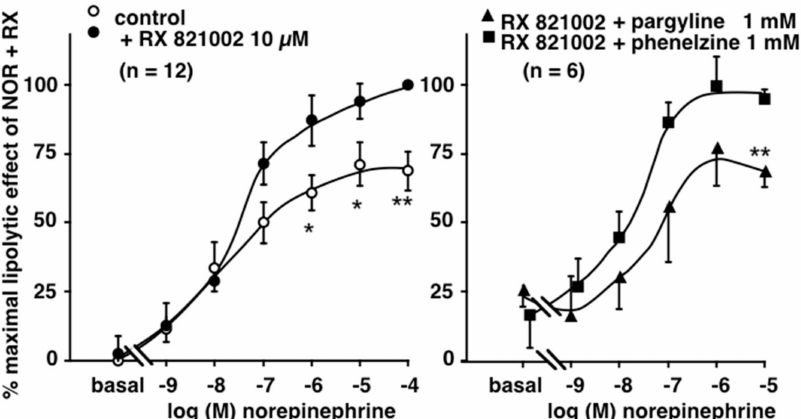
Figure 6. Influence of the MAO inhibitors pargyline and phenelzine on the potentiation of norepinephrine-induced lipolysis by α 2-adrenergic blockade. Left panel: dose–response curves of glycerol release were obtained with norepinephrine alone (control, open circles) or in the presence of RX 821002 (NOR + RX, closed circles). Results are expressed as percentage of maximal response to NOR + RX. Mean ± SEM of 12 adipocyte preparations. Di ff erent from respective NOR + RX at *: p < 0.05; **: p < 0.01. Right panel: Influence of phenelzine (triangles) pargyline (squares) at 1 mM on the RX 821002-induced potentiation of norepinephrine lipolytic activation. Mean ± SEM of six cases. Di ff erent from NOR + RX at **: p <